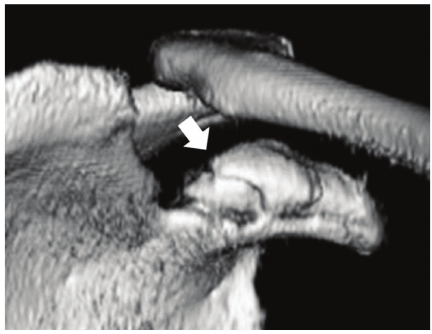
Figure 2: A 3D-CT reconstruction clearly reveals a small bone fragment at the CP medial apex